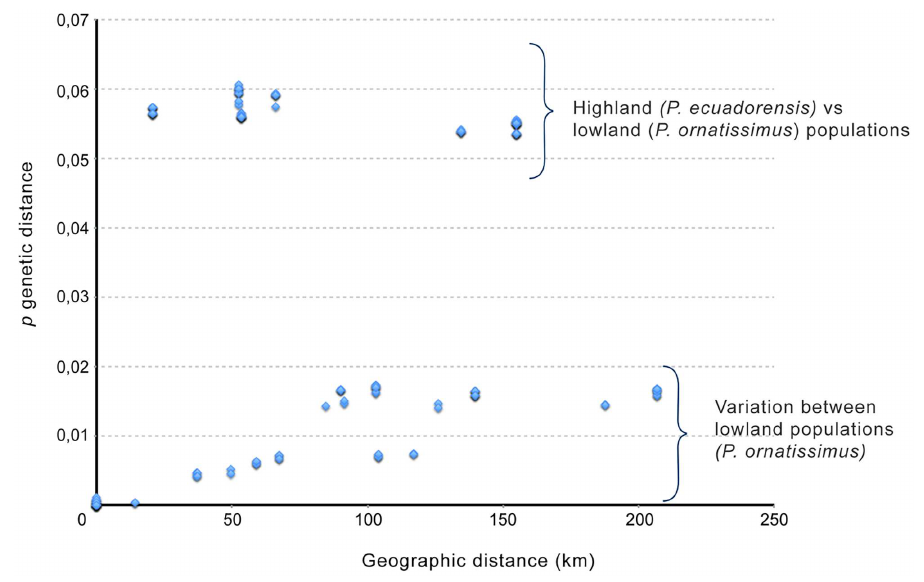
Fig 5. Isolation-by-distance among sequenced individuals. Note than populationsfrom highlands( P . ecuadorensis ) are much more divergent from P . ornatissimus sensu stricto than expectedbased on geographicdistance(see